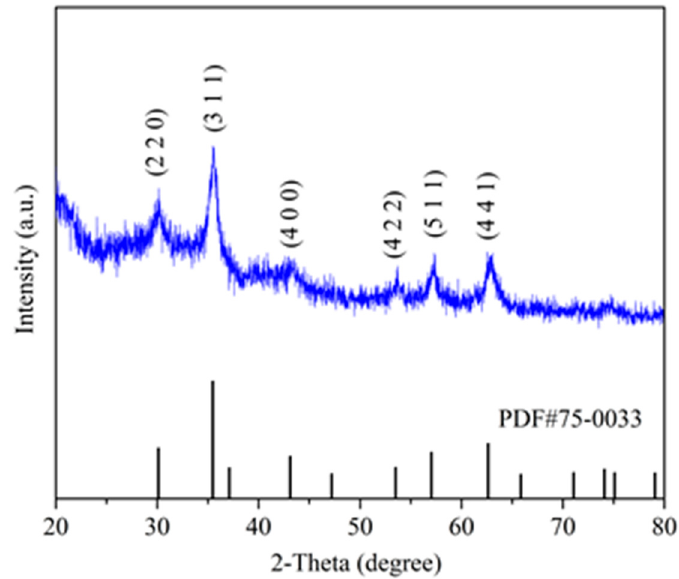
Figure 3. X-ray di ff raction spectrum of MY. Figure 3. X-ray diffraction spectrum of MY. Figure 3. X-ray diffraction spectrum of MY.